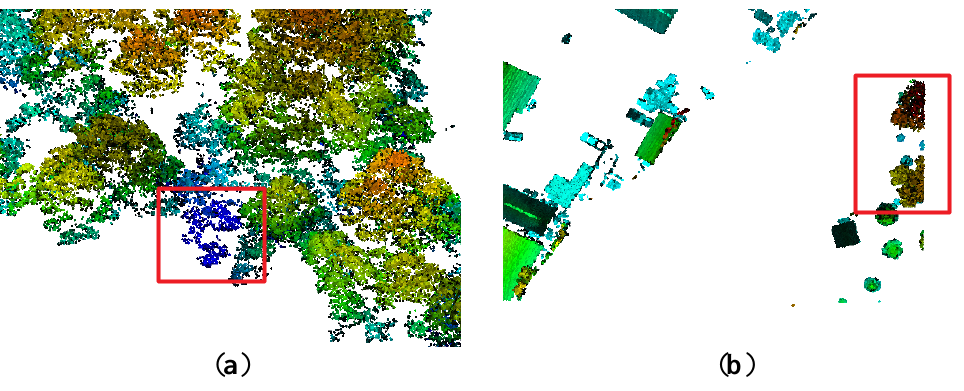
Figure 12. Error types for tall tree extraction: ( a ) Shrubs misrecognized as tall trees; ( b ) Missed tall